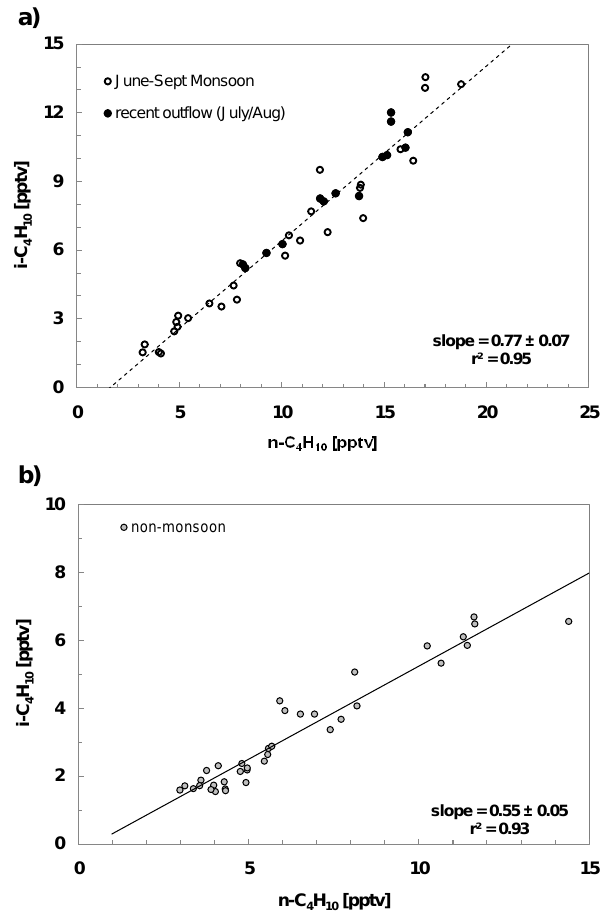
Fig. 6. Correlation plots of i-butane vs. n-butane from (a) sam- ples collected in monsoon outflow and (b) samples collected out- side of the monsoon season (April–May and October–December) on the FRA-MAA route. The slope in (a) is for the recent outflow only. The uncertainties represent the 95% confidence intervals of the